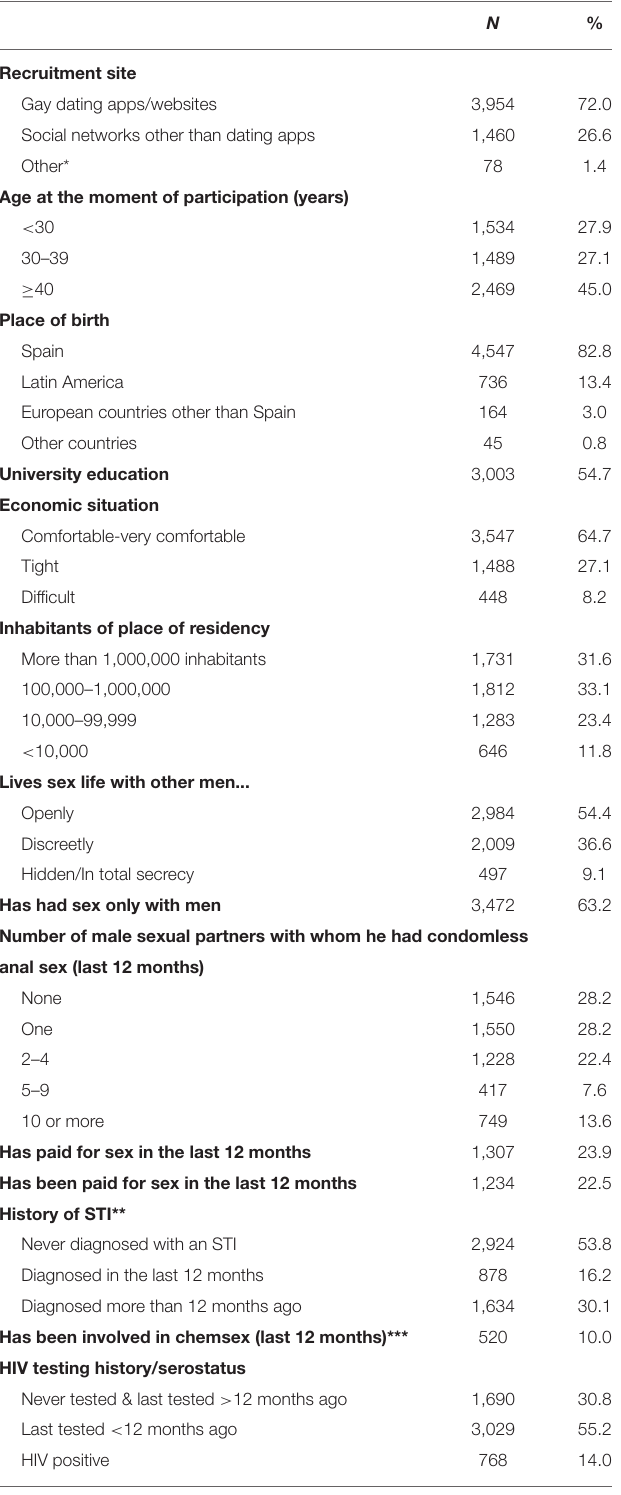
TABLE 1 | Main characteristics of study participants ( N =